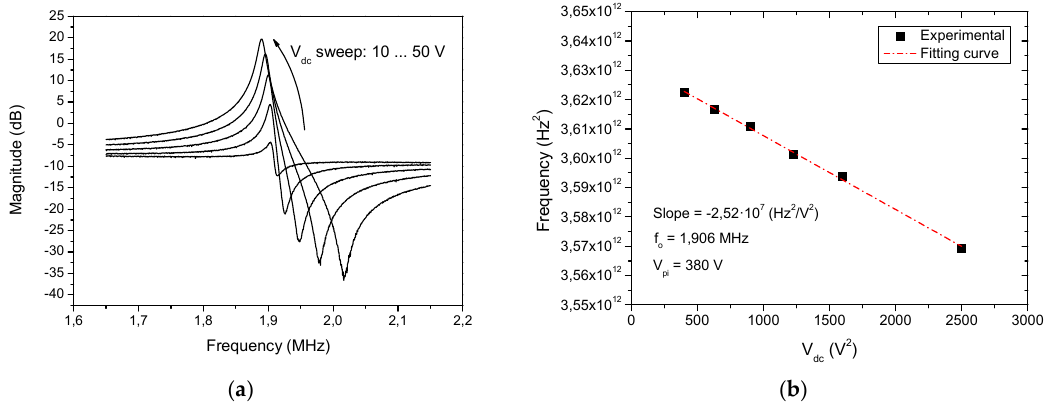
Figure 5. Electrical characterization of the suspended plate resonator with on-chip 0.35-μm CMOS readout circuit in open-loop configuration: ( a ) Measured frequency response (magnitude) for different resonator bias voltages ( V dc ) in air conditions; ( b ) Plot of the resonance frequency dependency versus the applied bias voltage.